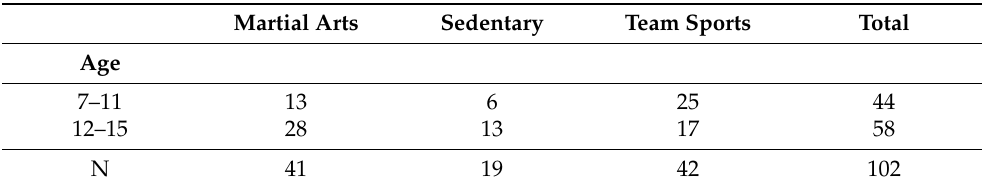
Table 1. Number of participants for age group and sport